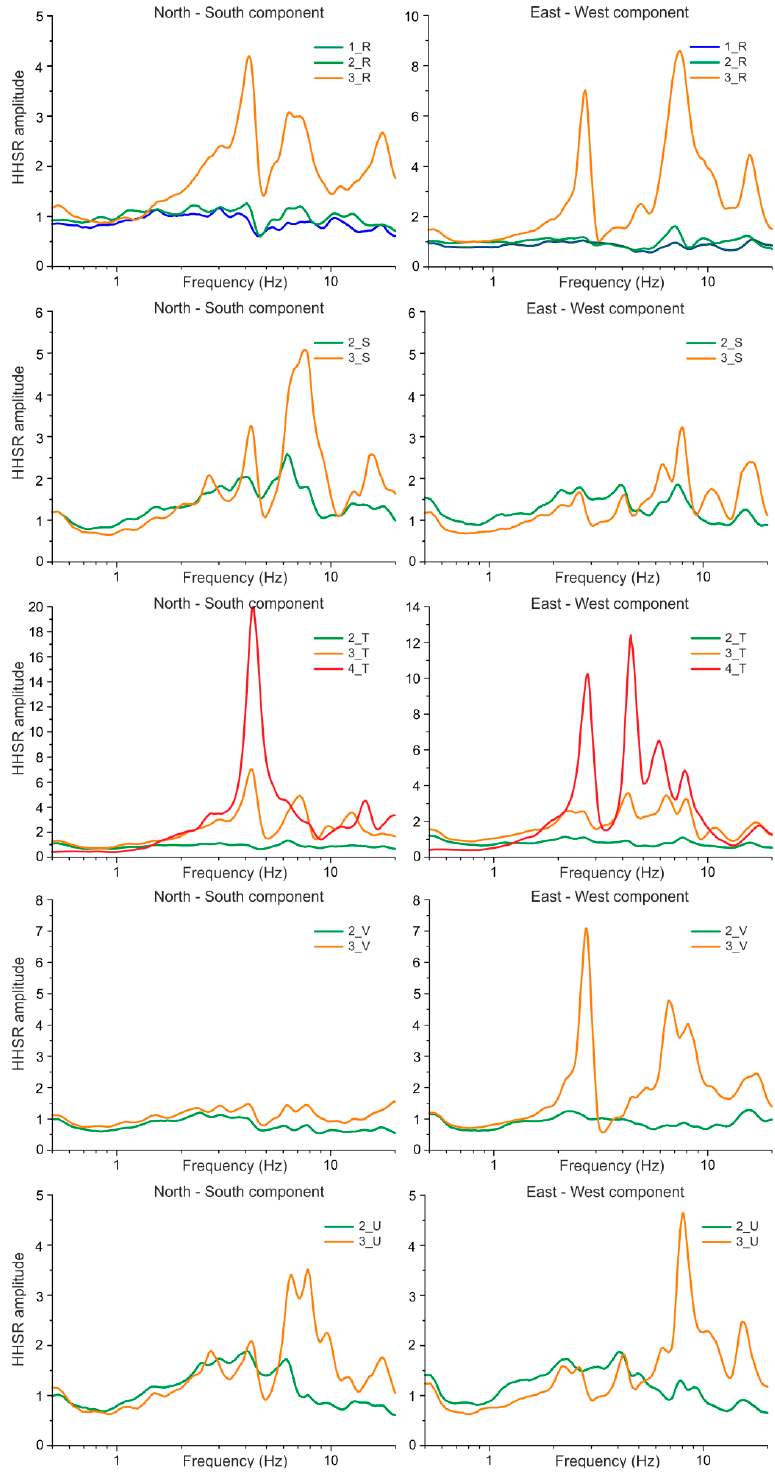
Figure 7. HHSR plots obtained from noise recordings performed at floors one (basement) to five (roof) for the sites R, S, T, U, and